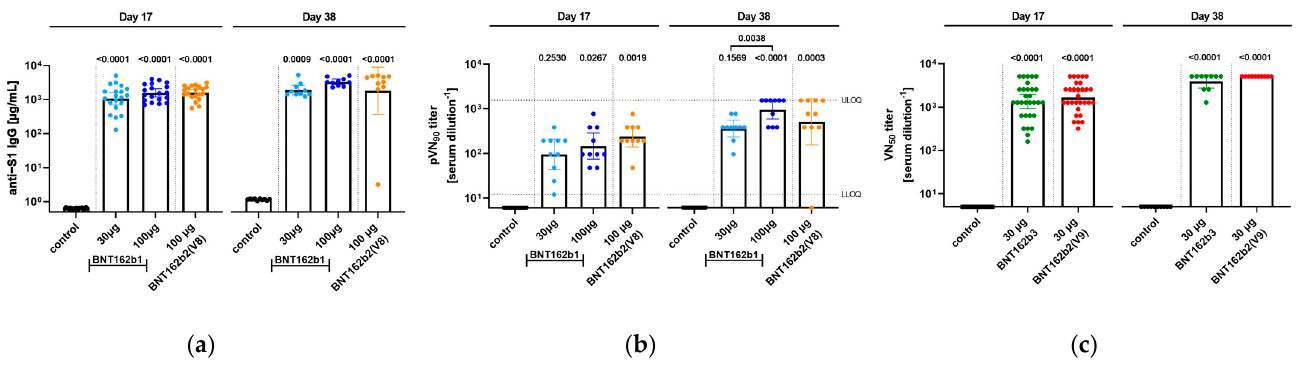
Figure 9. Wistar Han rats were immunized intramuscularly (IM) with BNT162b1, BNT162b2, or BNT162b3 vaccine candidates or buffer control. Analysis of serum samples was performed 17 days [ n = 20] or 38 days [( a , b ): n = 10; ( c ): n =5] after first immunization. Geometric means of each group ± 95% confidence interval (CI) are included, and p -values are given to control or determine if significance occurred as indicated (One-Way ANOVA of mixed-effect analysis using Tukey’s multiple comparisons test). ( a ), S1-specific IgG levels in sera of rats determined by ELISA. ( b ), 90% pseudovirus neutralization (pVN90) titers in sera of rats immunized with the different BNT162b vaccine candidates. ( c ), 50% SARS-CoV-2 neutralization (VN50) titer in sera of rats immunized with different BNT162b vaccine candidates.